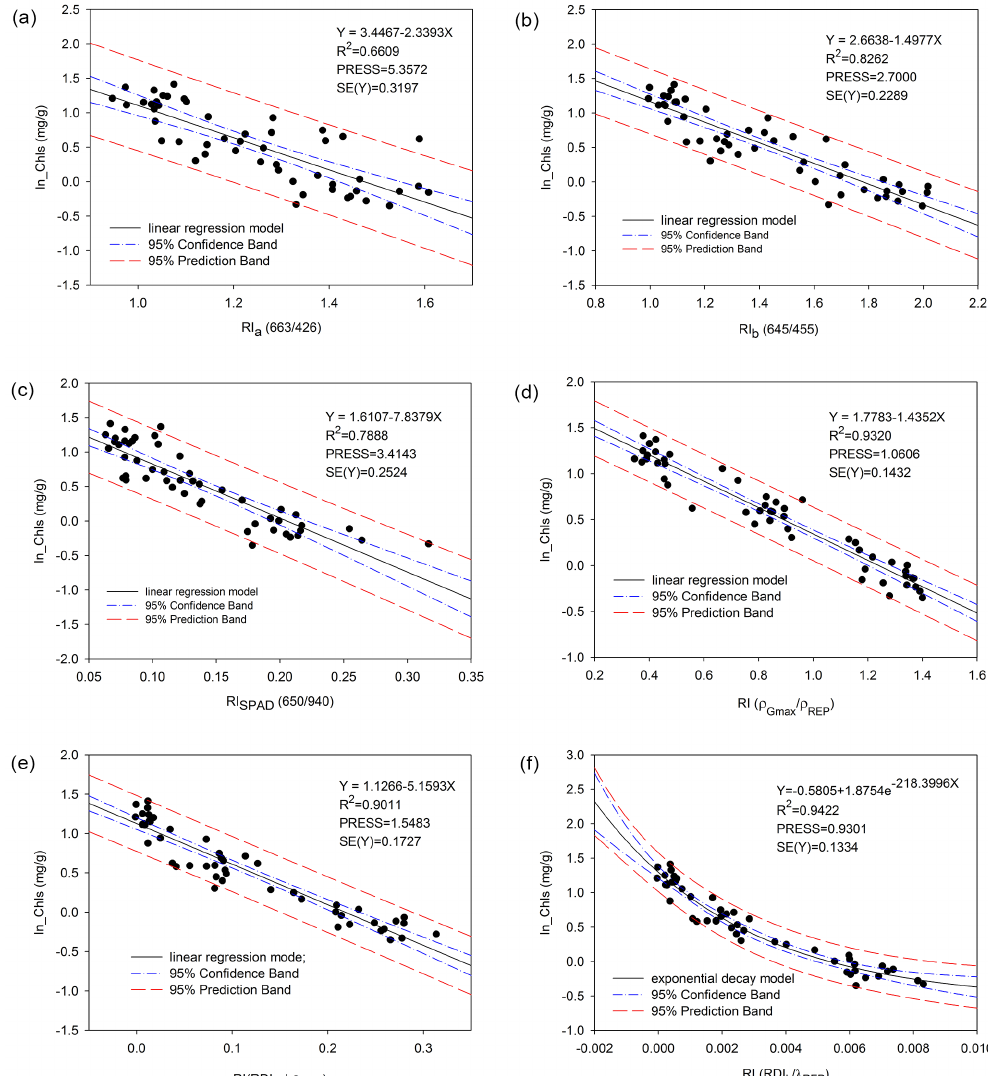
Figure 6. Ratio-index-based empirical models for foliar Chls concentration